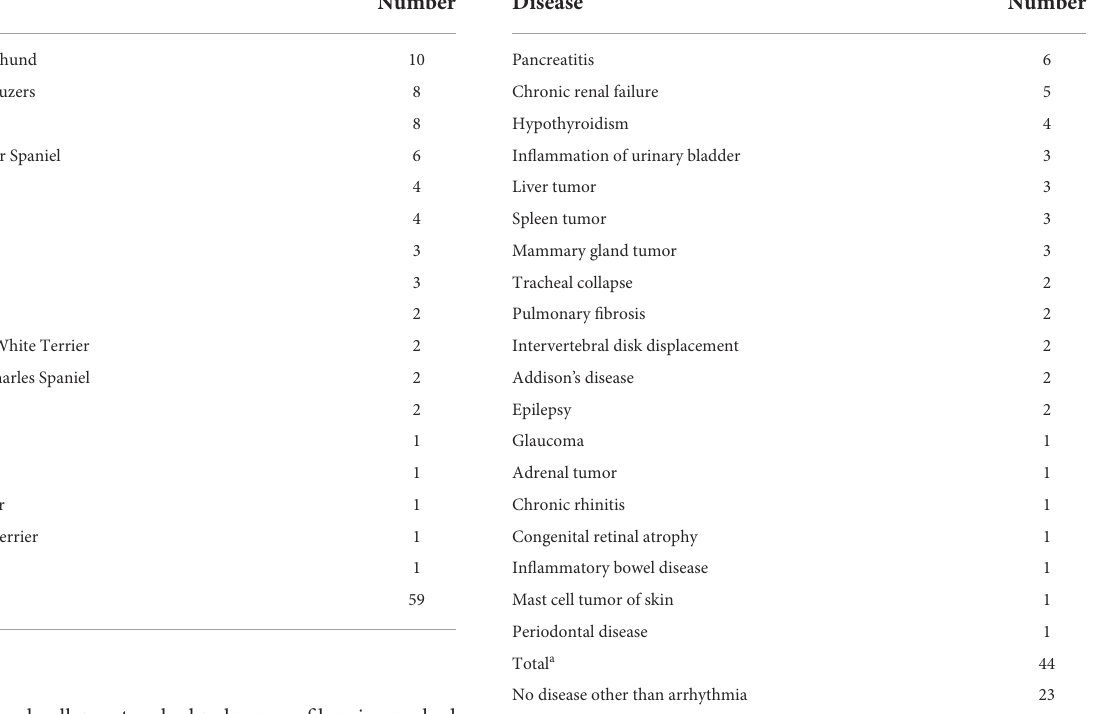
TABLE 1 Composition of dog breeds in this study. TABLE 2 Diseases of patients other than heart